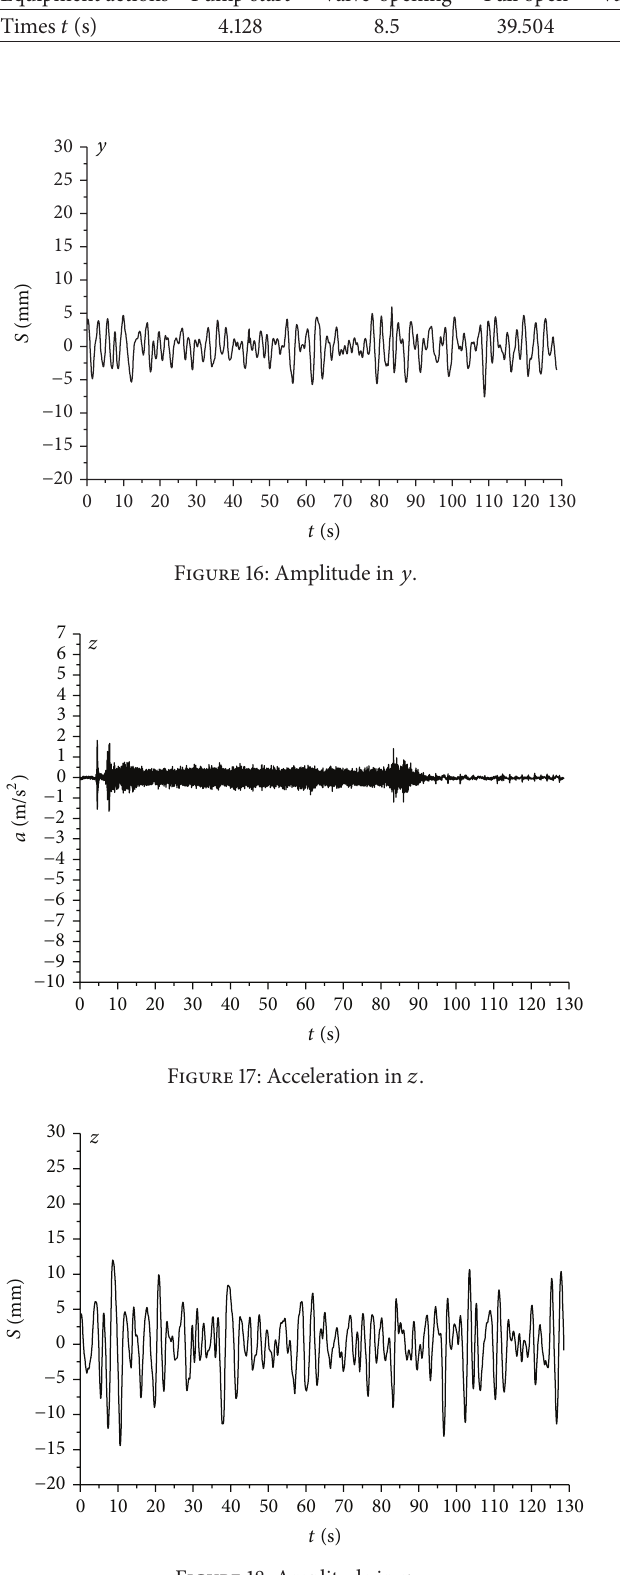
Figure 18: Amplitude in 𝑧 .